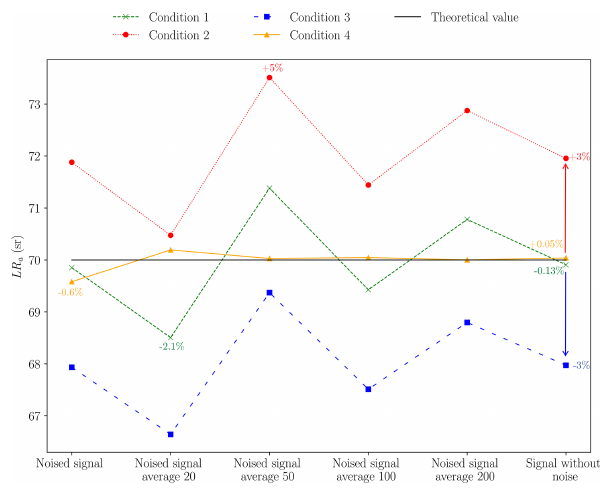
Figure 6. Retrieved LR a for six datasets and four different condi- tions of inversion.